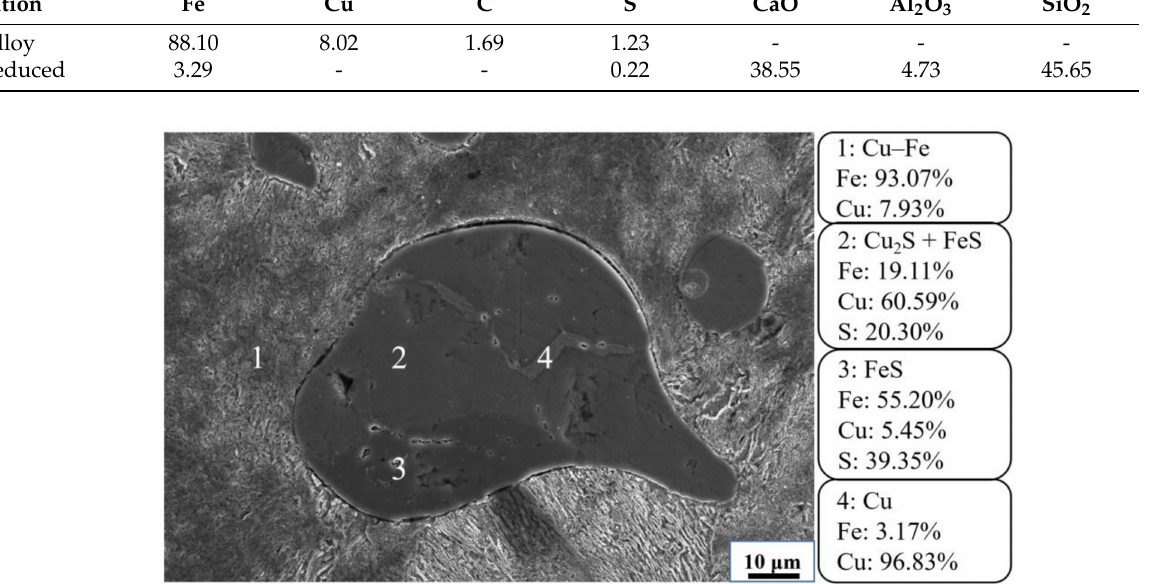
Figure 1. Electron microscope of Cu–Fe